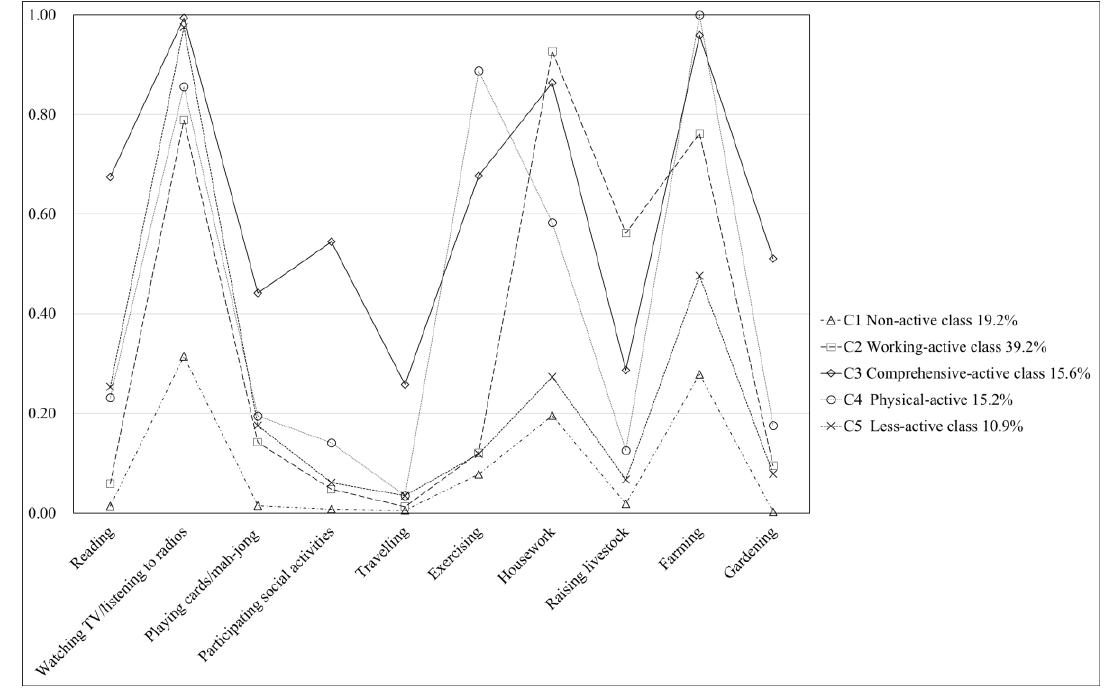
Figure 1. Conditional probability of ten types of activity engagement for the latent classes. Class 1 = Non-active class, Class 2 = Working-active class, Class 3 = Comprehensive-active class, Class 4 = Physical-active, Class 5 = Less-active class.